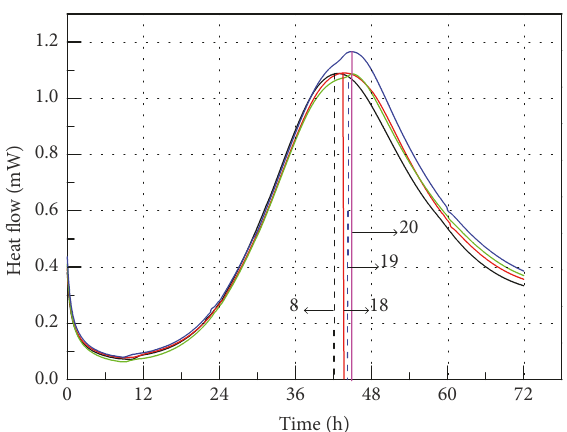
Figure 20: Heat flow versus time of references with SRA-SCA.